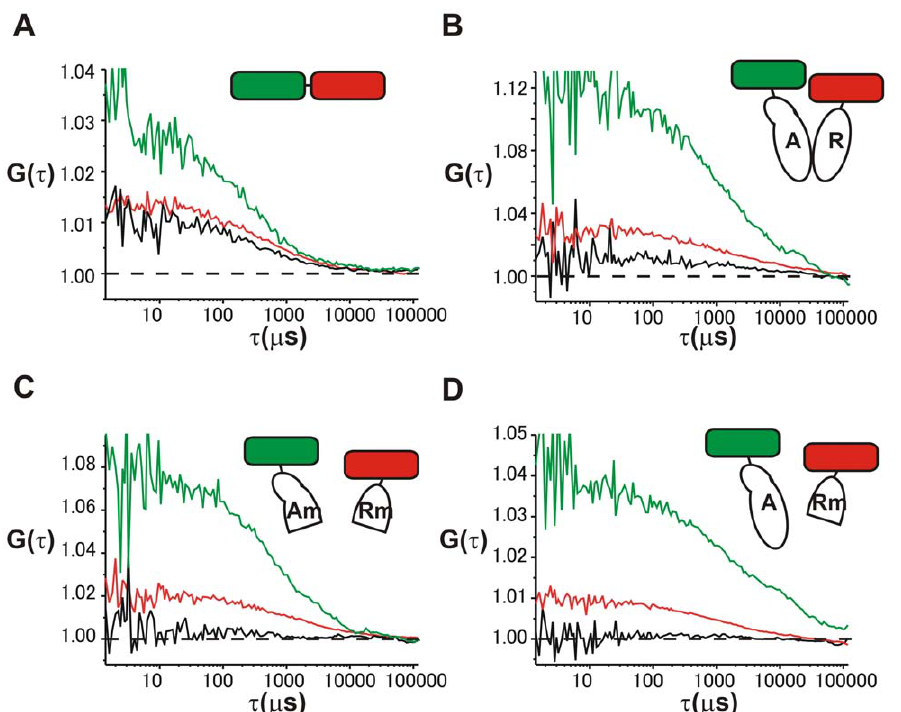
Figure 2. FCCS measurement of differently labeled CREB1 isoforms in the nuclei of living cells. The inset is a schematic diagram showing fluorescent-labeled proteins used with each experiment. Auto- and cross-correlation curves of fluorescent-labeled proteins were shown for EGFP- mRFP chimera protein (A), EGFP-Act and mRFP-Rep (B), EGFP-Act mut and mRFP-Rep mut(C), and EGFP-Act and mRFP-Rep mut (D), respectively. The green curve denotes the auto-correlation of the green channel [ G g( t )], the red curve the auto-correlation in the red channel [ G r( t )] and the black curve the cross-correlation curve [ G c( t )].